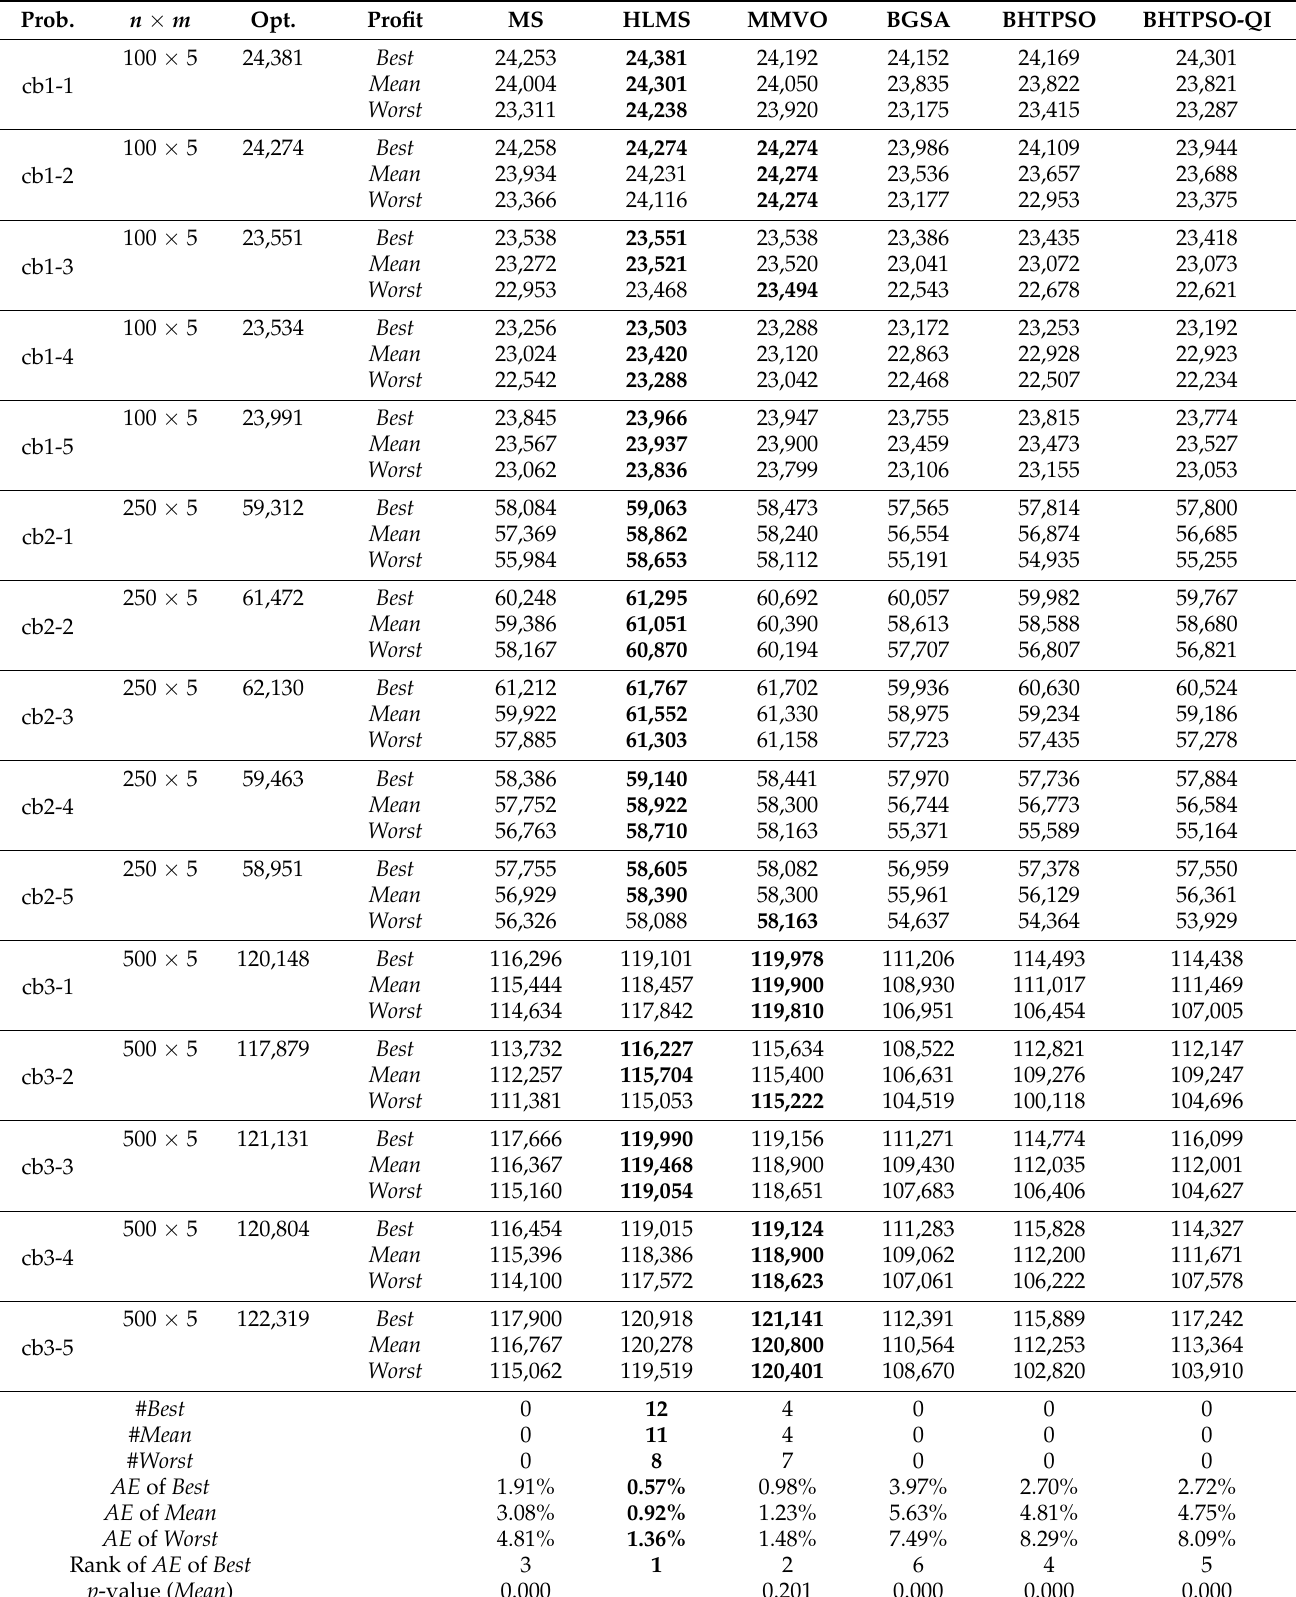
Table 4. The results of HLMS with 5 comparative algorithms for Test set III (cb1-cb3).